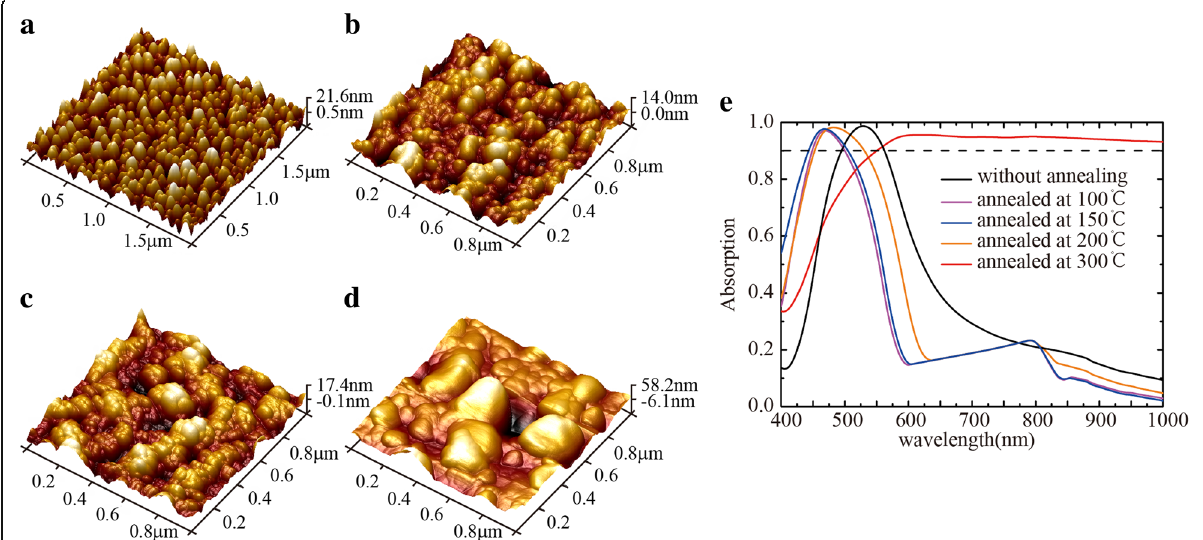
Fig. 6 AFM images and absorption curves of Ag-Cu NP absorbers. a Without annealing, b annealed at 100°C, c annealed at 150°C, and d annealed at 300°C. e The absorption curves of the absorber annealed at different temperatures